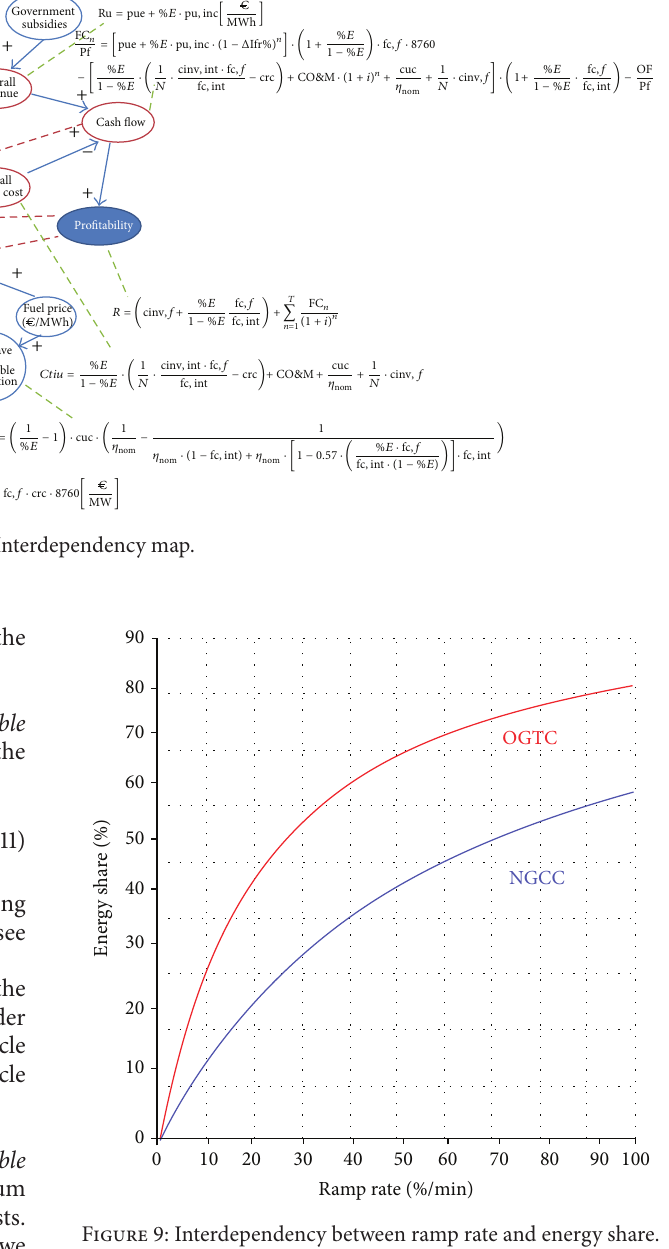
Figure 9: Interdependency between ramp rate and energy